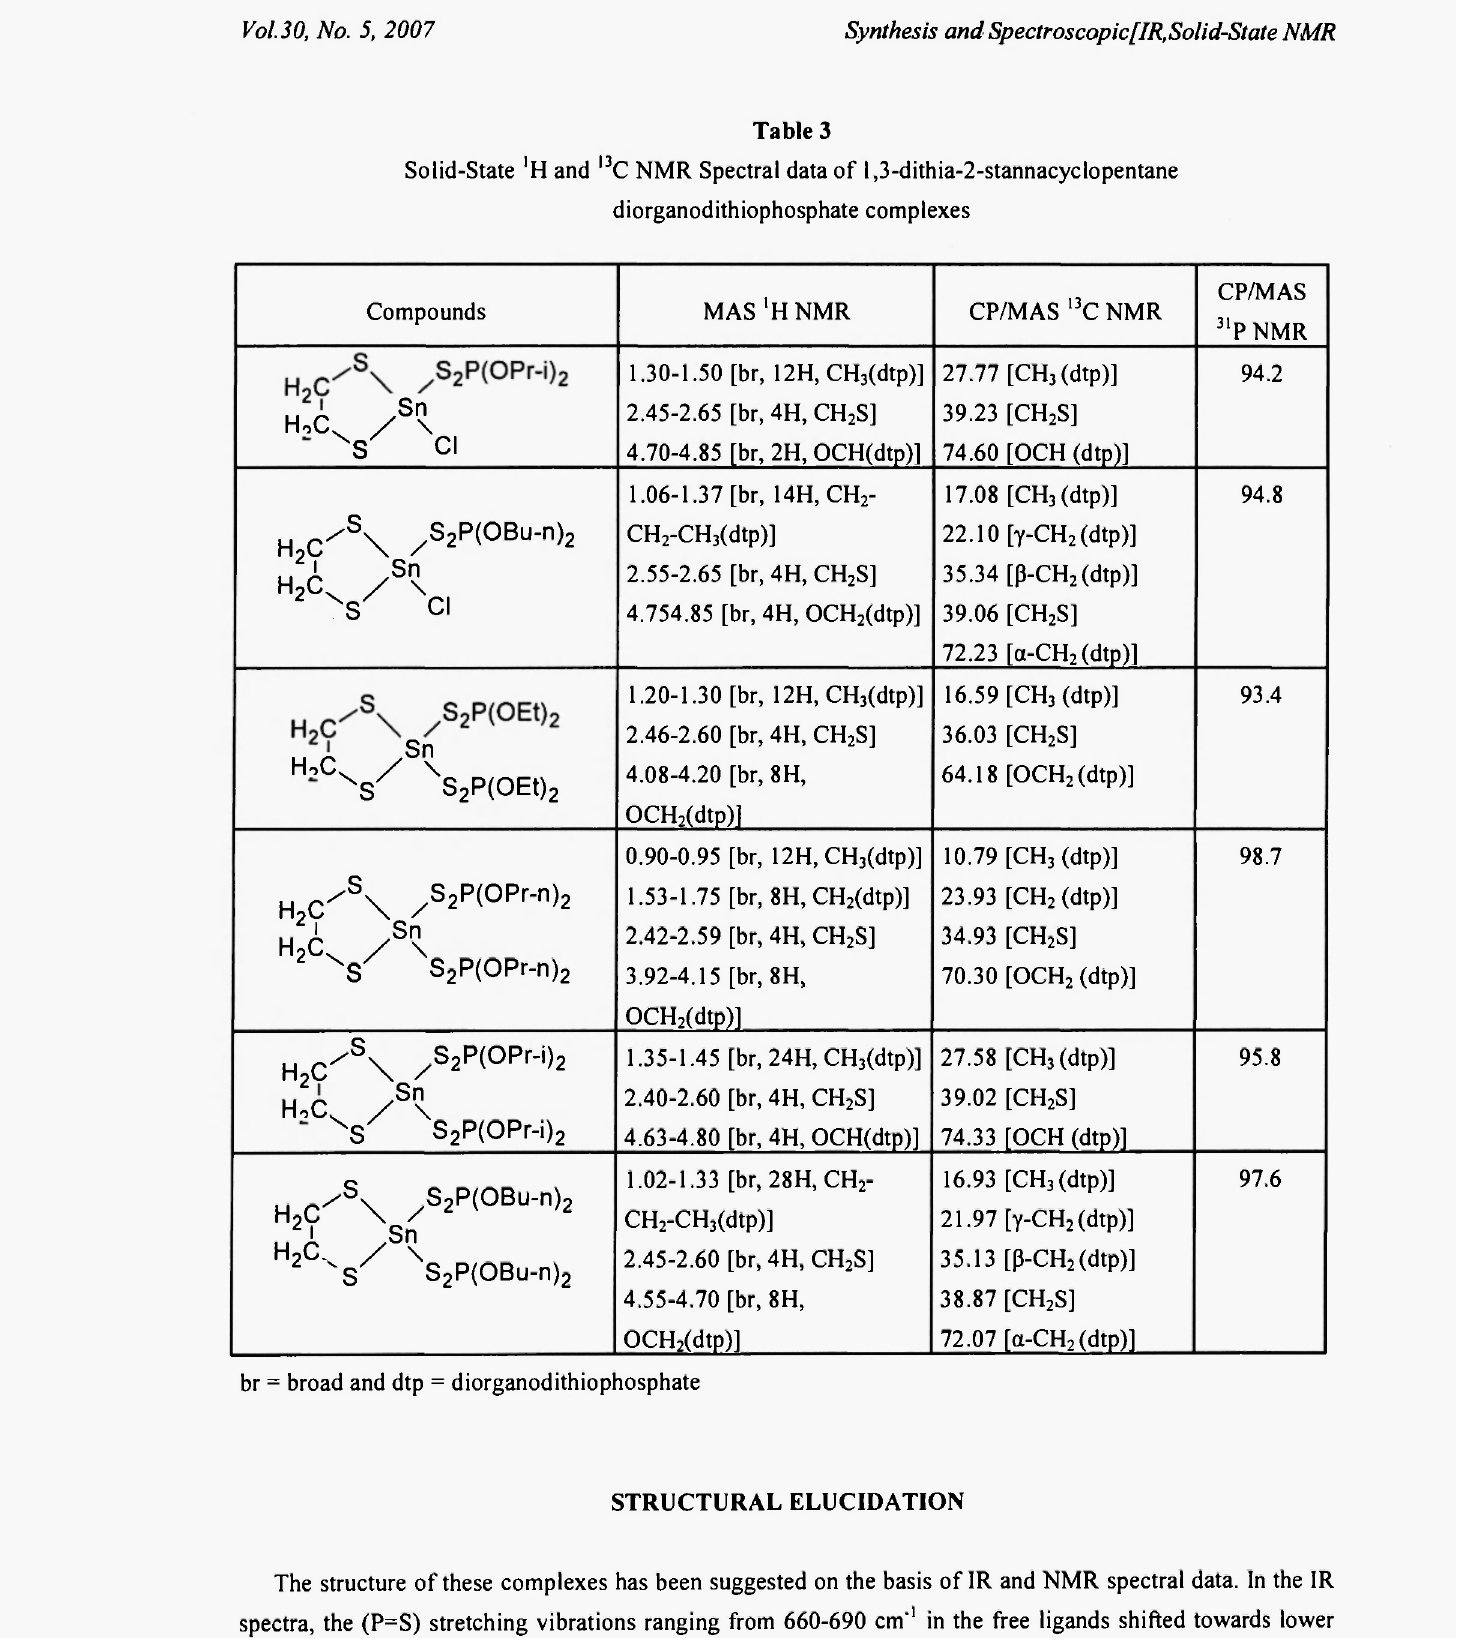
Solid-State 'H and 13 C NMR Spectral data of